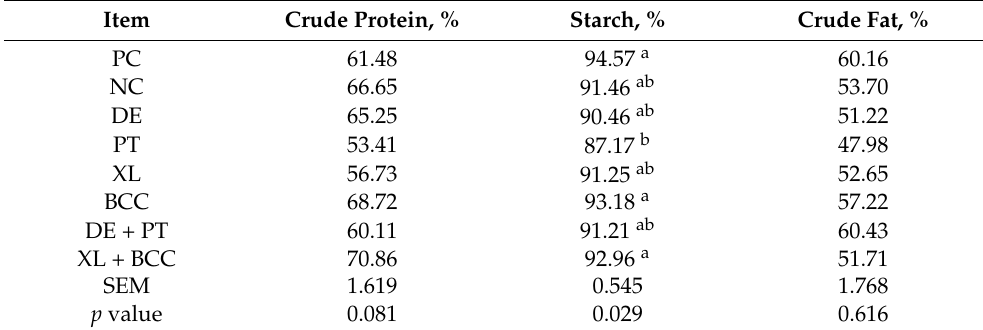
Table 6. Supplemental enzymes with probiotics on nutrient digestibility of broiler chickens at 21